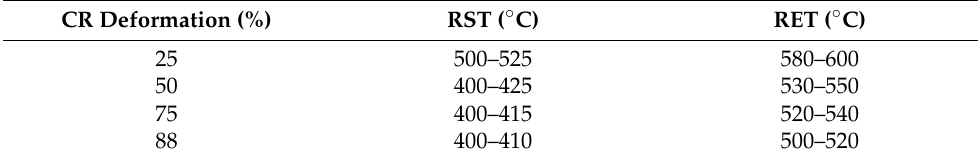
Table 2. The obtained RST and RET values at different CR deformation